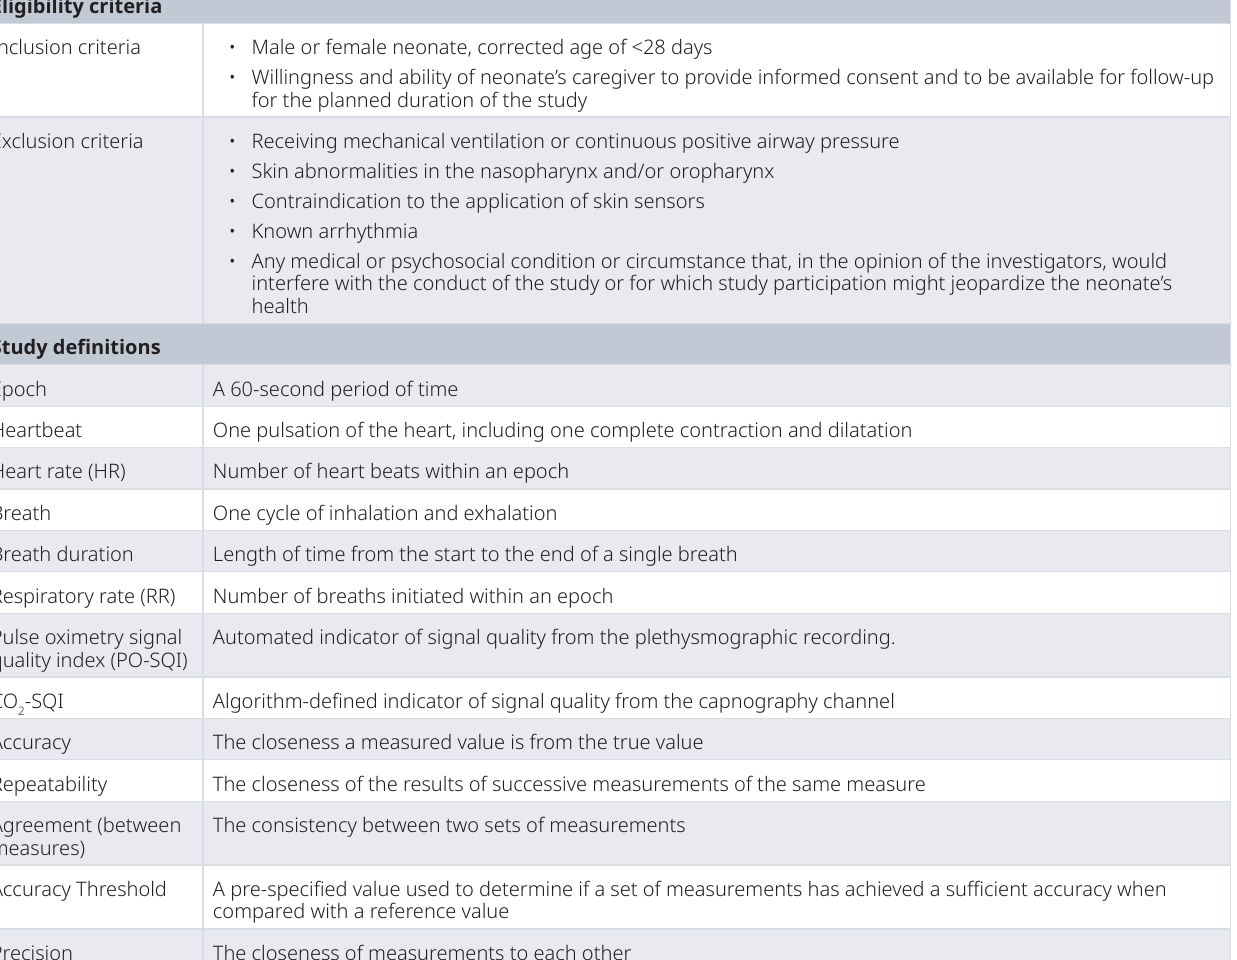
Table 1. Study eligibility criteria and definitions.